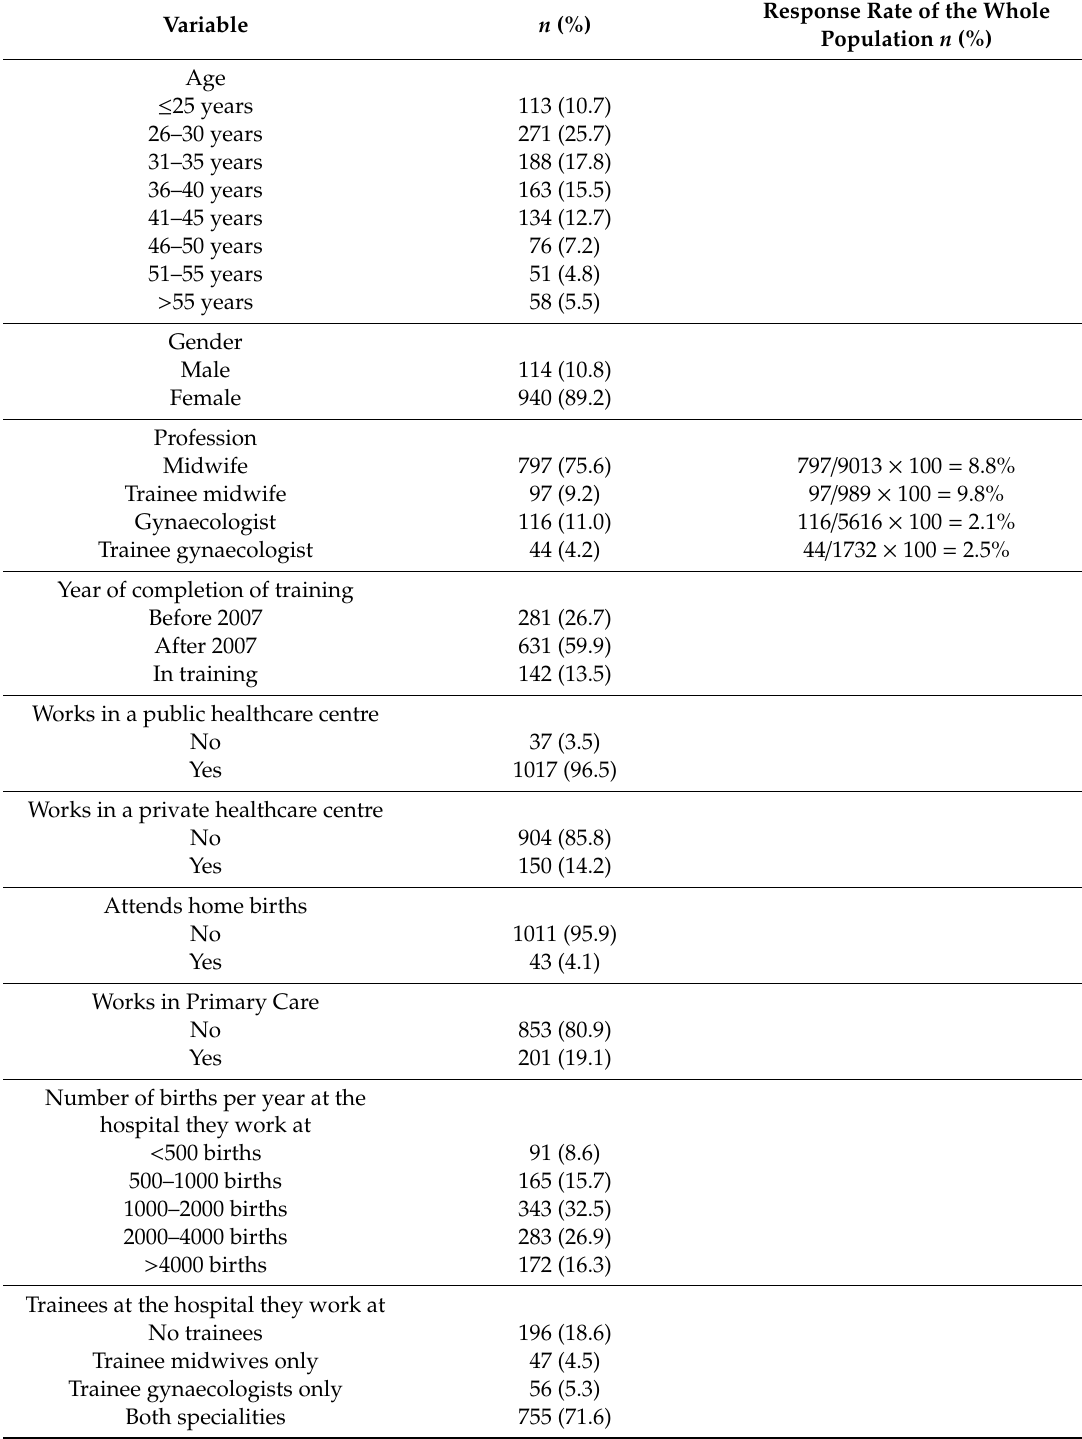
Table 1. Professional role and work